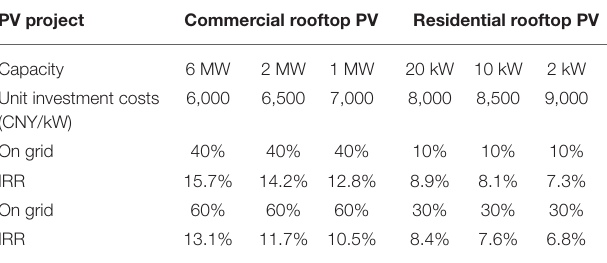
TABLE 7 | The impact of on-grid share on the LCOE and IRR of rooftop PV in Beijing. PV project